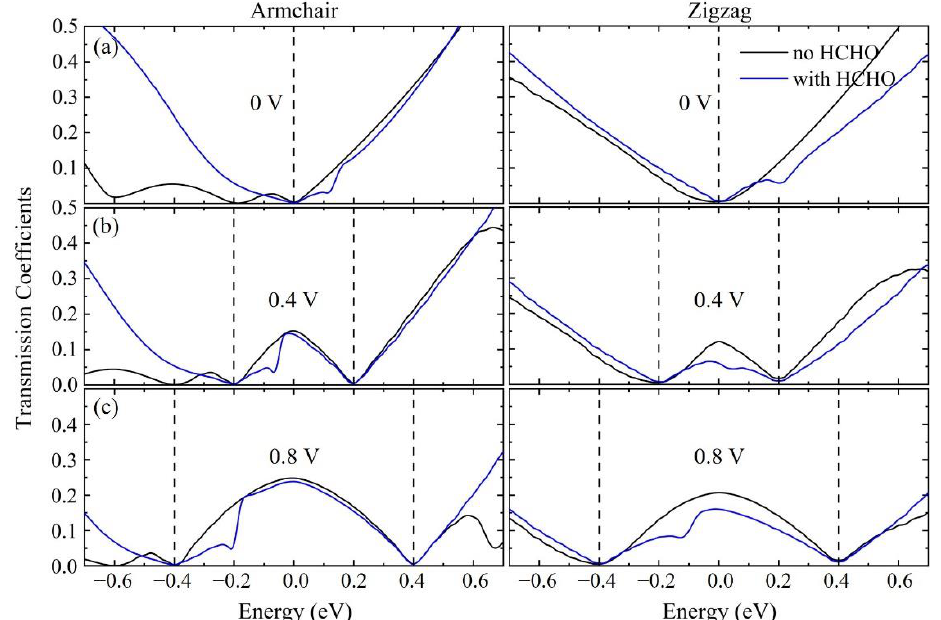
Figure 8. The transmission spectra of MgG nano-sensor for HCHO detection along armchair and zigzag direction under the bias voltage of ( a – c ) 0, 0.4, and 0.8 V. The black dashed lines represent the bias windows.